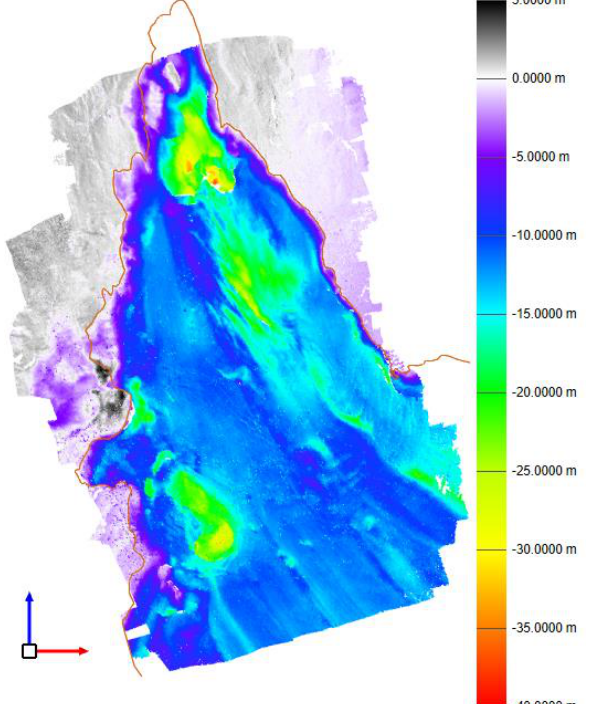
Figure 2. Height comparison map between 2014 DPC co- registered using CP2016 method and 2016 DPC.